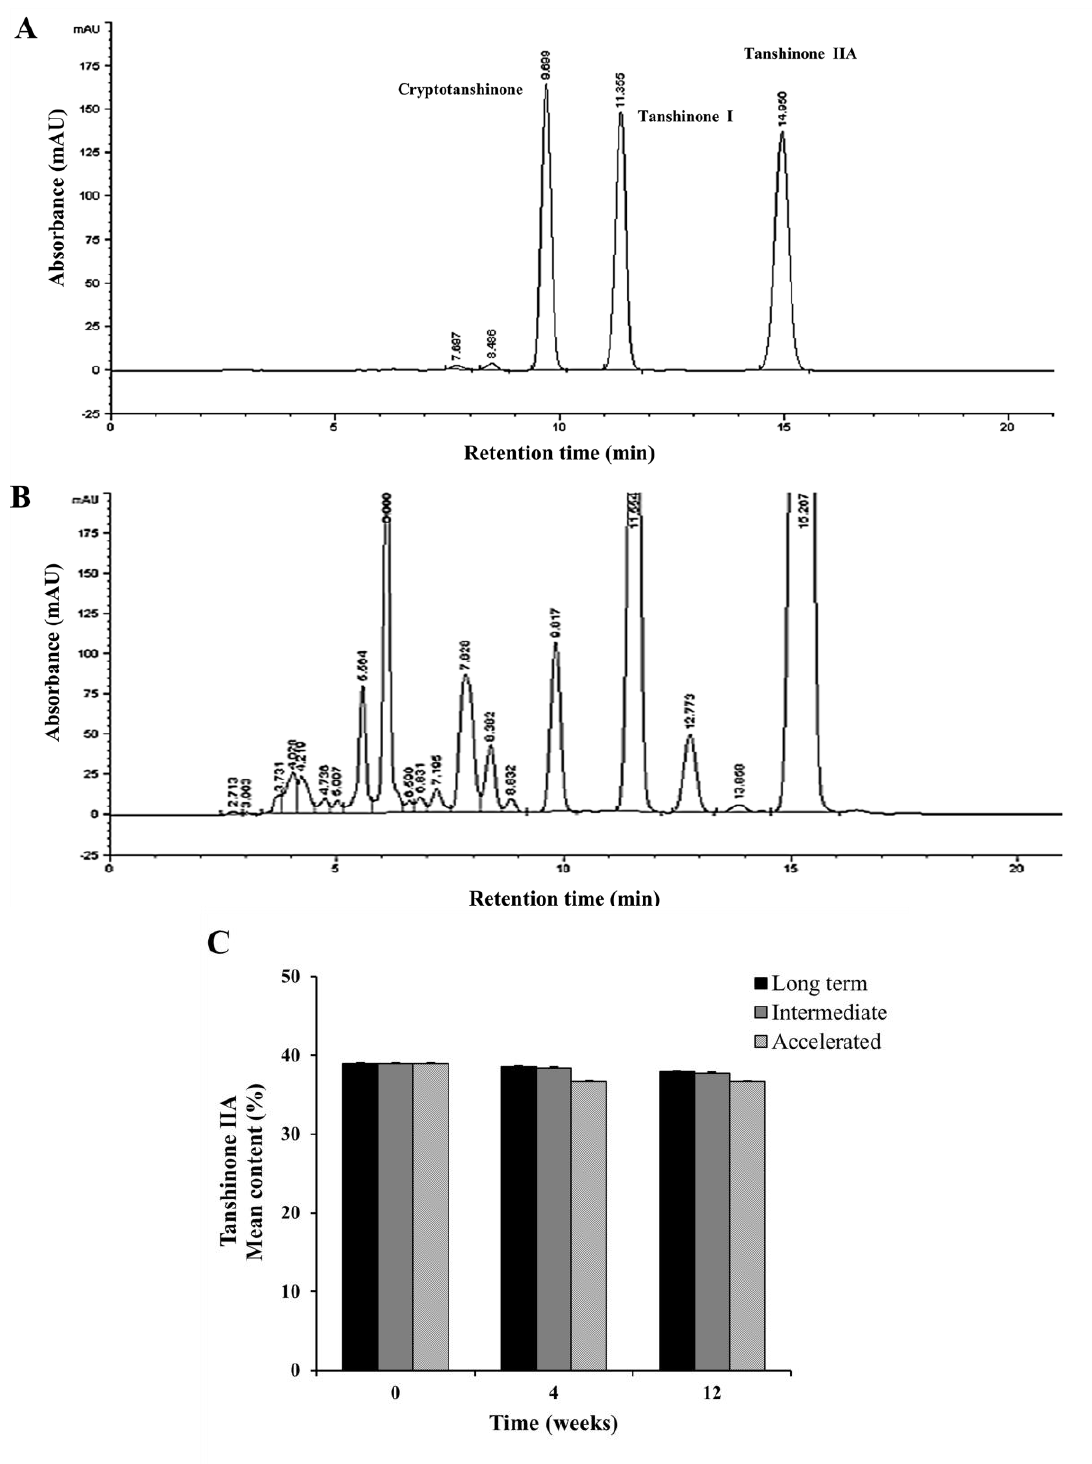
Figure 4. Effect of storage conditions on tanshinone IIA content in SME. ( A ) The HPLC chromatogram of the standard tanshinone mixture solution shows an absorption peak with a retention time of 14.950 min; ( B ) This peak is also present in the HPLC chromatogram of the SME, indicating the presence of tanshinone IIA; ( C ) The storage conditions did not significantly change the tanshinone IIA content between the initial test and the final